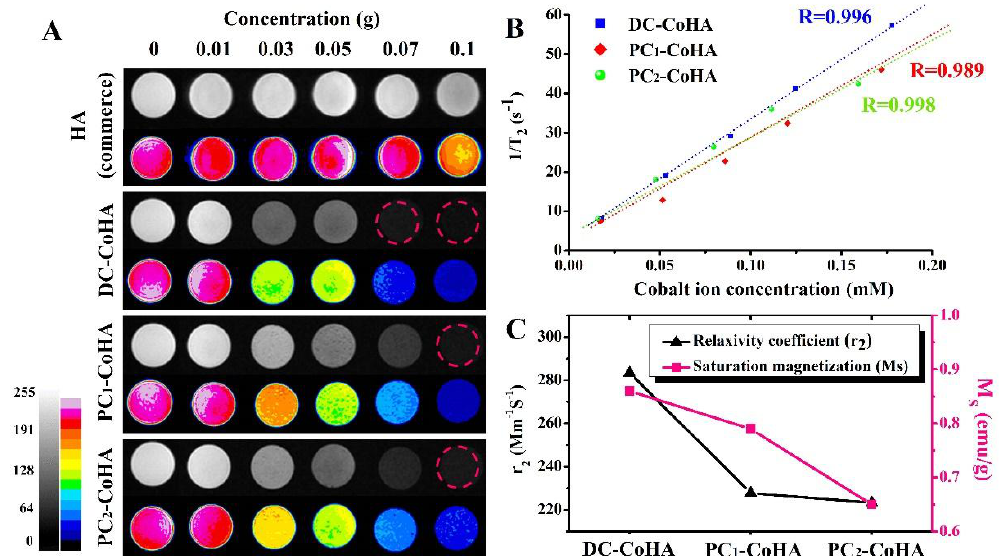
Figure 8. ( A ) T 2 -weighted magnetic resonance imaging (MRI) images of hydroxyapatite (HA) (commerce), DC-CoHA, PC 1 -CoHA and PC 2 -CoHA suspended in gelatinat at different concentrations; ( B ) the T 2 relaxation rate R 2 (1/ T 2 ) against cobalt concentration of CoHA; ( C ) relaxivity coefficient ( r 2 ) and saturation magnetization (Ms) of the relative relationship.